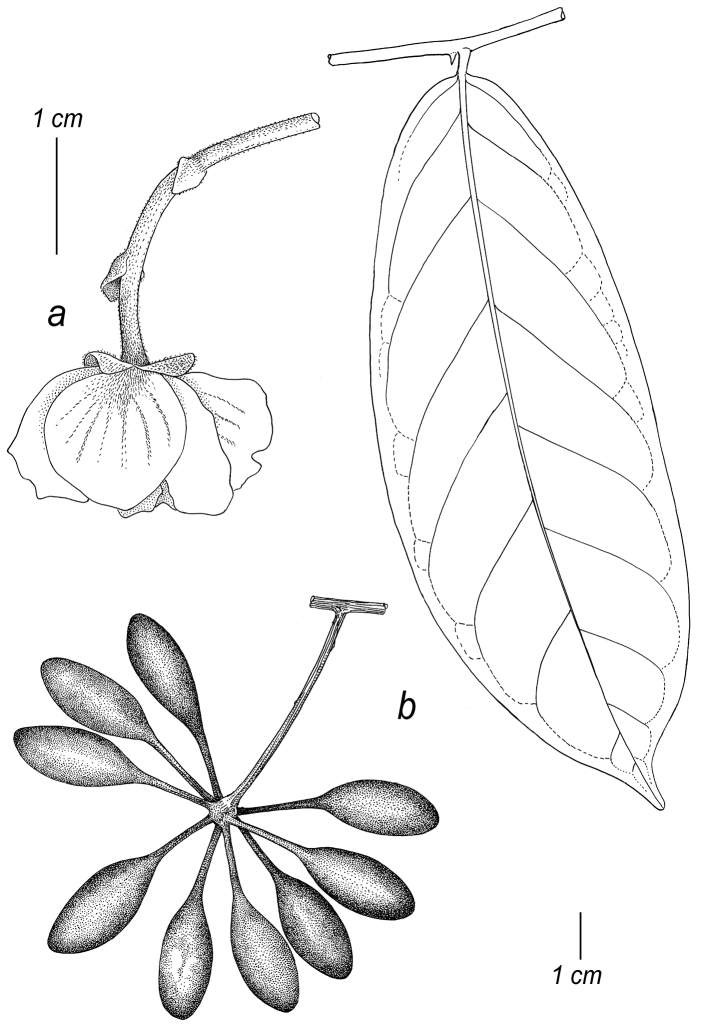
Cremastospermadolichocarpum Pirie. a flower b leaf and fruit (aCallejas 3110bSánchez 415).